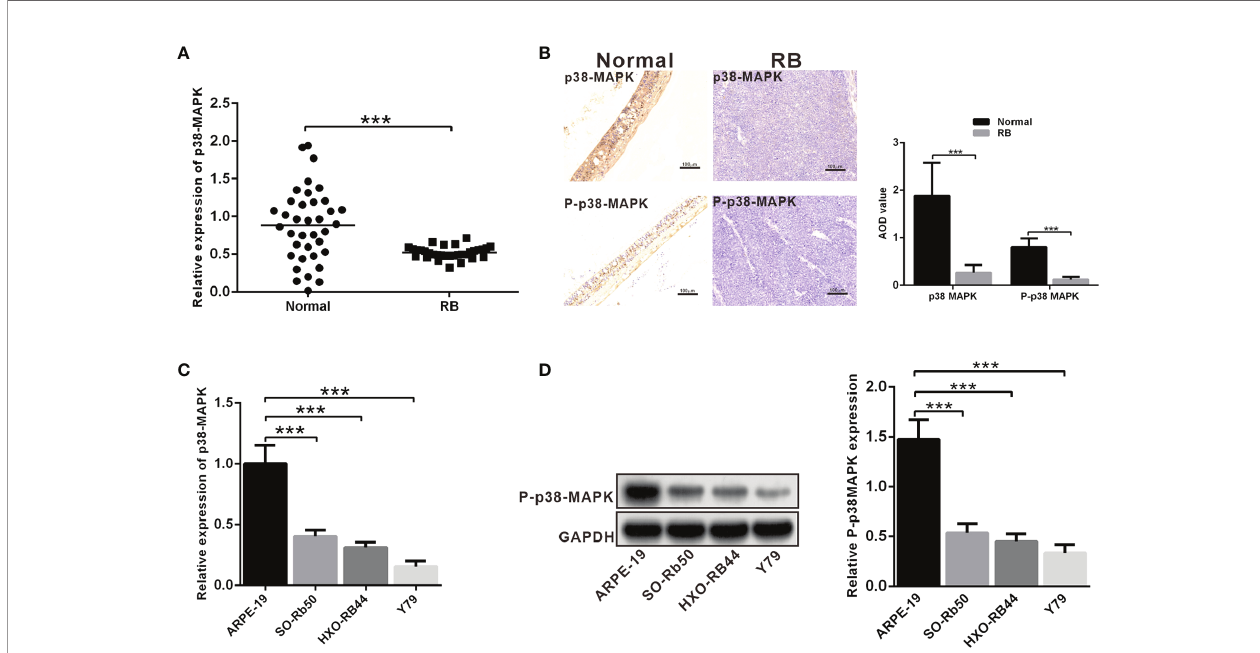
FIGURE 1 | The expression of p38 MAPK and P-p38 MAPK is depleted in RB tissues and cells. (A) p38 MAPK expression in RB tissues was detected using RT- qPCR (n = 32). (B) Expression of p38 MAPK and P-p38 MAPK in clinical samples was measured using IHC assay (n = 32). The p38 MAPK and P-p38 MAPK average optical density (AOD, analysis by soft wear Image J) in RB were signi fi cant lower than in normal retina tissues. (C) p38 MAPK expression in ARPE-19, SO- Rb50, HXO-RB44 and Y79 cells was assessed by RT-qPCR. (D) P-p38 MAPK expression in ARPE-19, SO-Rb50, and HXO-RB44 and Y79 cells was assessed by western blot analysis. *** p < 0.001. The measurement data was expressed by mean ± standard deviation. The two groups of data conforming to the normal distribution were compared using unpaired t